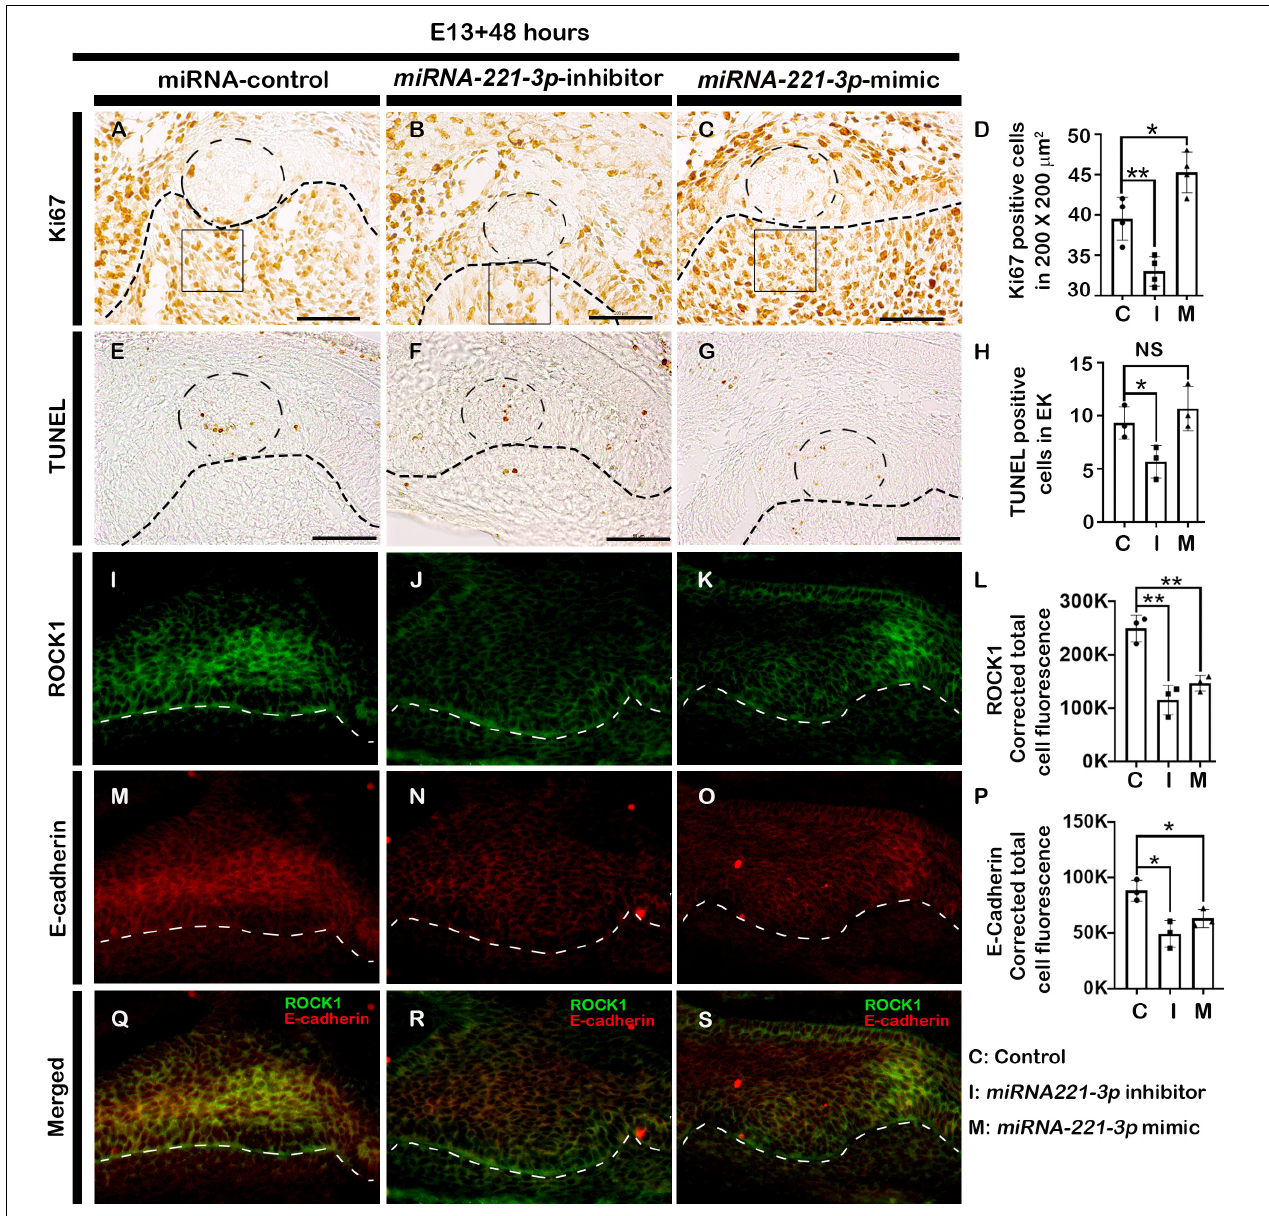
FIGURE 2 | Altered cellular events after loss and gain of function of miRNA-221-3p . The cellular proliferations especially at the EK and dental mesenchyme adjacent to the IEE increased in the mimic and decreased in the inhibitor-treated tooth germs ( A–D , n = 4). Loss and gain of miRNA-221-3p at E13 for 2 days show decreased apoptotic cells along the EK of inhibitor-group compared to control and mimic ( E–H , n = 3). Localizations of ROCK1 (green) (I–L) ( n = 3) and E-cadherin (red) ( M–O , n = 3) along the enamel organ, showing decreased intensities in the inhibitor and mimic specimens, compared to control ( Q–S , n = 3). The dotted circles in the IEE (A–C,E–G) define the EK, the dotted lines define the boundary of epithelium and mesenchyme (A–O) and the squares (A–C) defines the area where Ki67 positive cells are counted. EK, enamel knot. Data were evaluated for statistical significance using unpaired, two-tailed t -test. * and ** indicate p < 0.05 and 0.01, respectively, NS, not significant. Scale bars: 50 µ m (A–O)